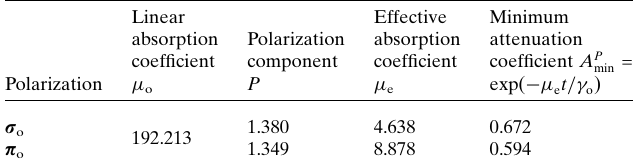
Table 1 (cid:9) o , (cid:9) e , A P for r o and p o polarizations in the 111 ; (cid:2) 1111 = 200 three-beam min reflection case for a Ge slab (thickness: 0.05 cm; X-ray entrance surface: (100); X-ray energy: 10 keV).